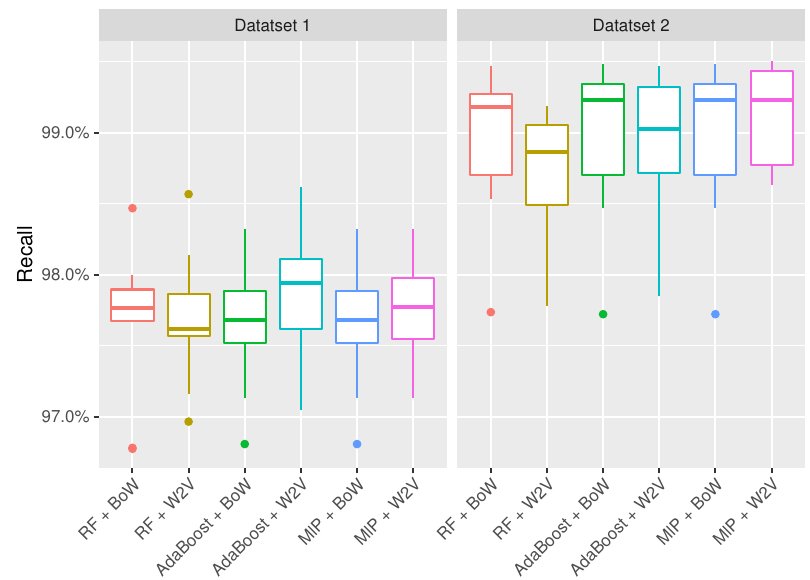
Figure 4. Cross validation values of the recall index for the prediction of the account codes (sent invoices).